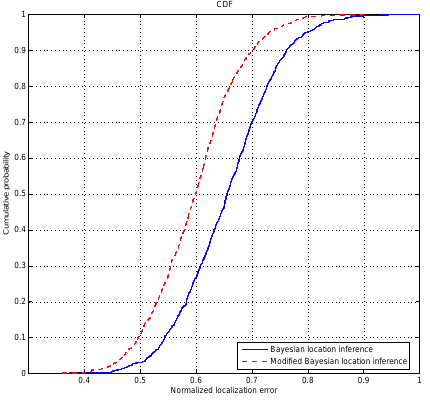
Figure 10. CDFs of normalized localization error